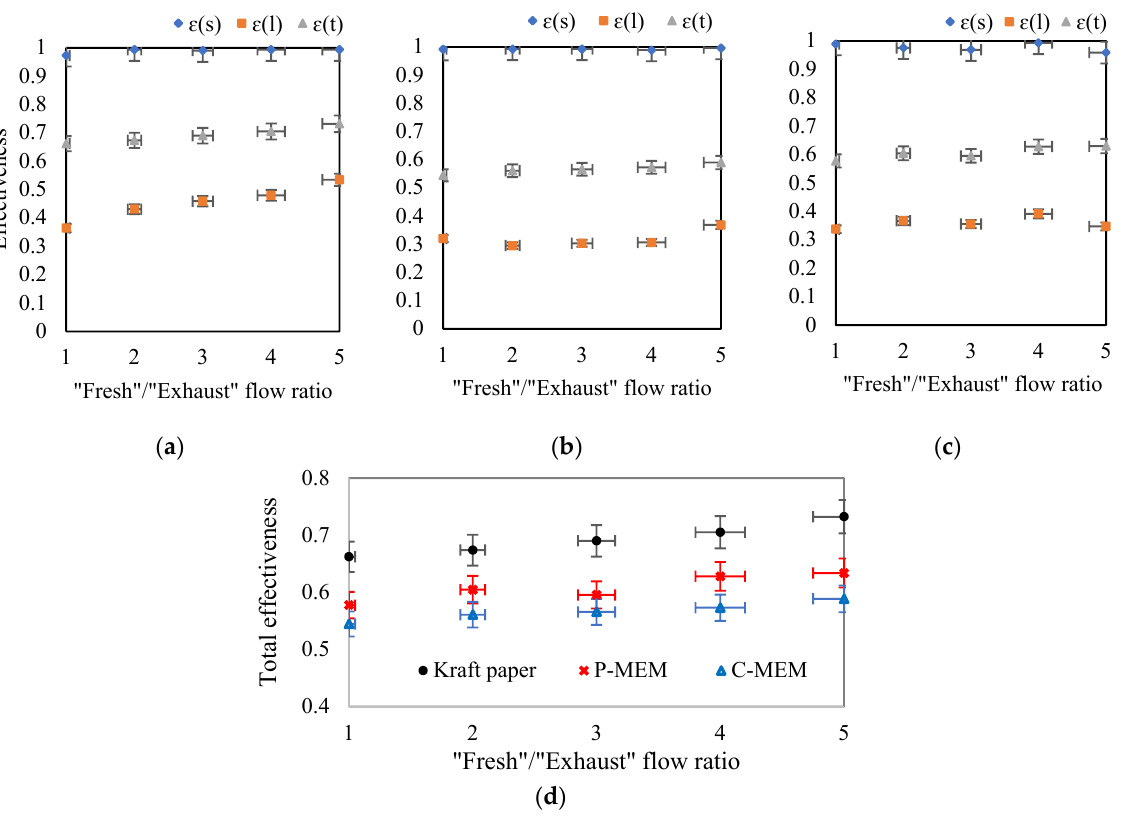
Figure 5. Effect of increasing the flow rate ratio of “fresh” to “exhaust” on sensible, latent, total effectiveness for ( a ) kraft paper, ( b ) C-MEM, and ( c ) P-MEM, ( d ) comparison of the total effectiveness of different membranes at different fresh/exhaust air flow ratios.